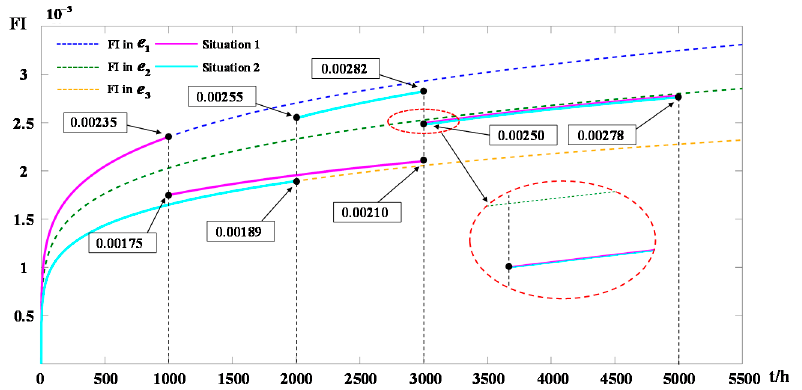
Figure 4. The FI results of the two situations.